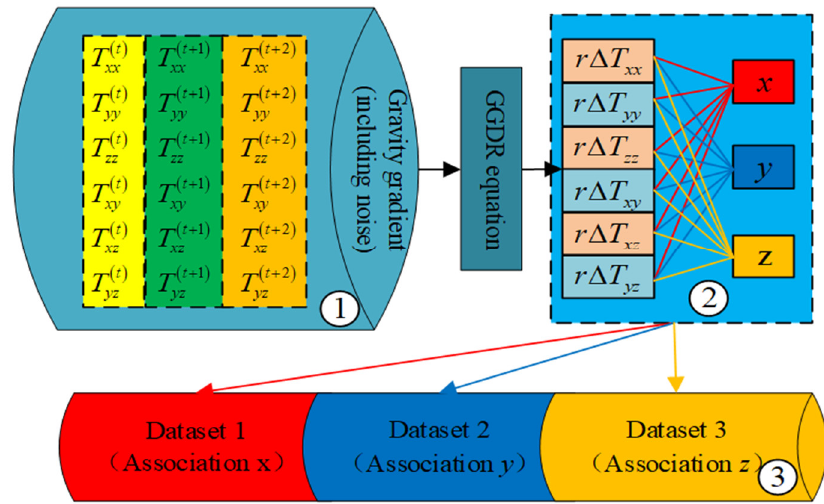
Figure 6. Differential ratio dataset construction process.